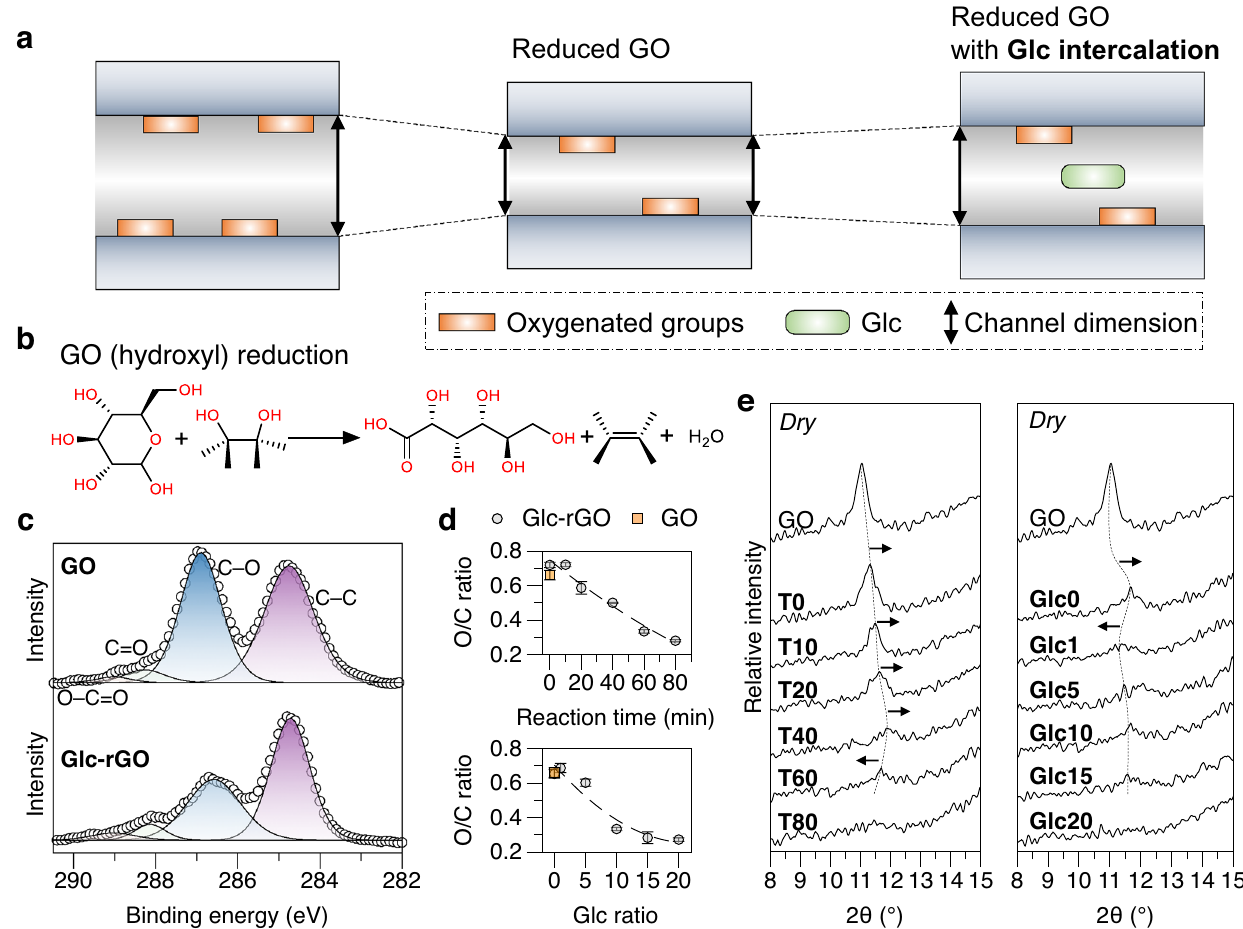
Fig. 2 | Fabrication of different GO membrane nanochannels. a Illustration of varied GO membrane nanochannel dimensions by reaction with Glc; b Chemical reaction of GO (hydroxyl) reduction by Glc; c XPS spectra of GO and a typical Glc- rGOsample(reactionperiod,60min;Glcratio,10); d O/CratioofGOanddifferent Glc-rGO samples from XPS analysis. The error bars represent the standard devia- tionsofthreemeasurements; e X-raydiffractionspectraofGOandGlc-rGOsamples